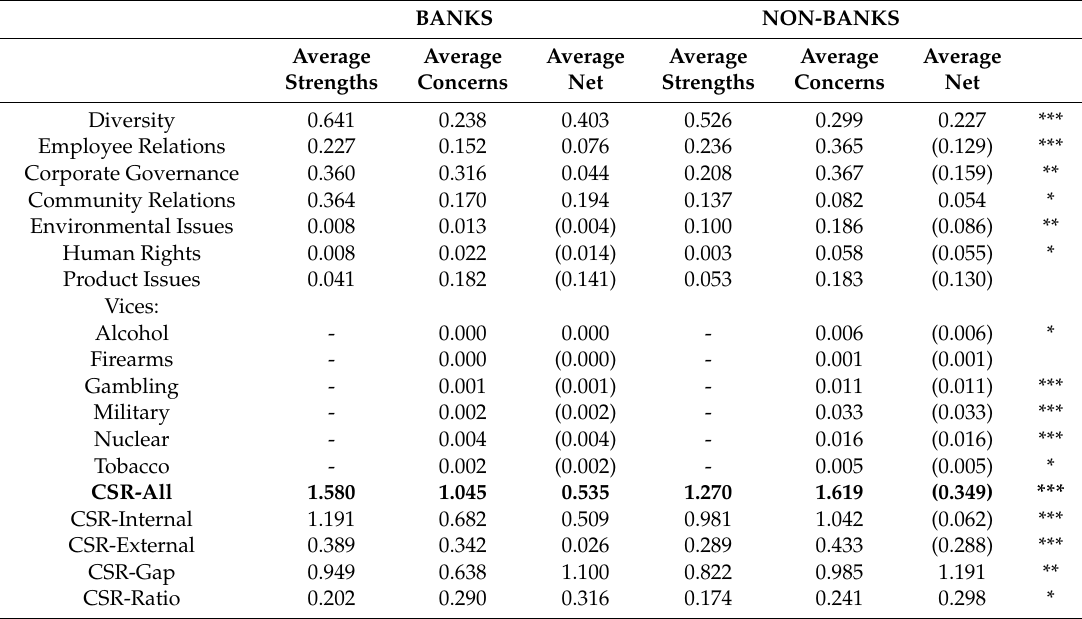
Table A1. Components of CSR Scores, Banks vs.